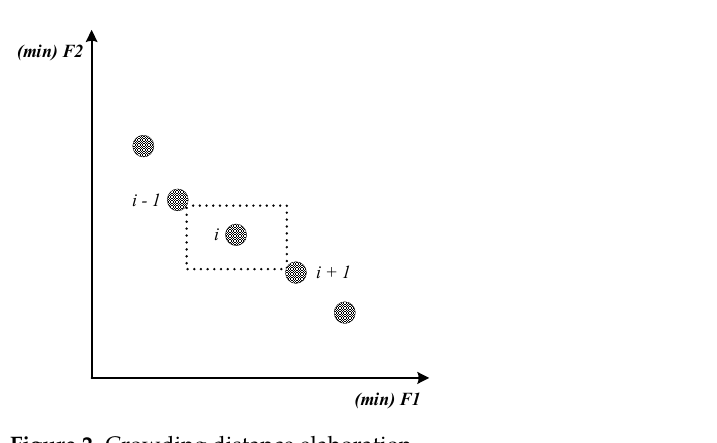
Figure 2. Crowding distance elaboration.